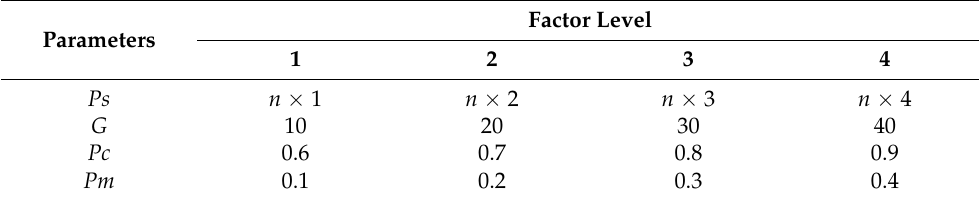
Table 2. Each algorithm corresponds to the impact factor level.